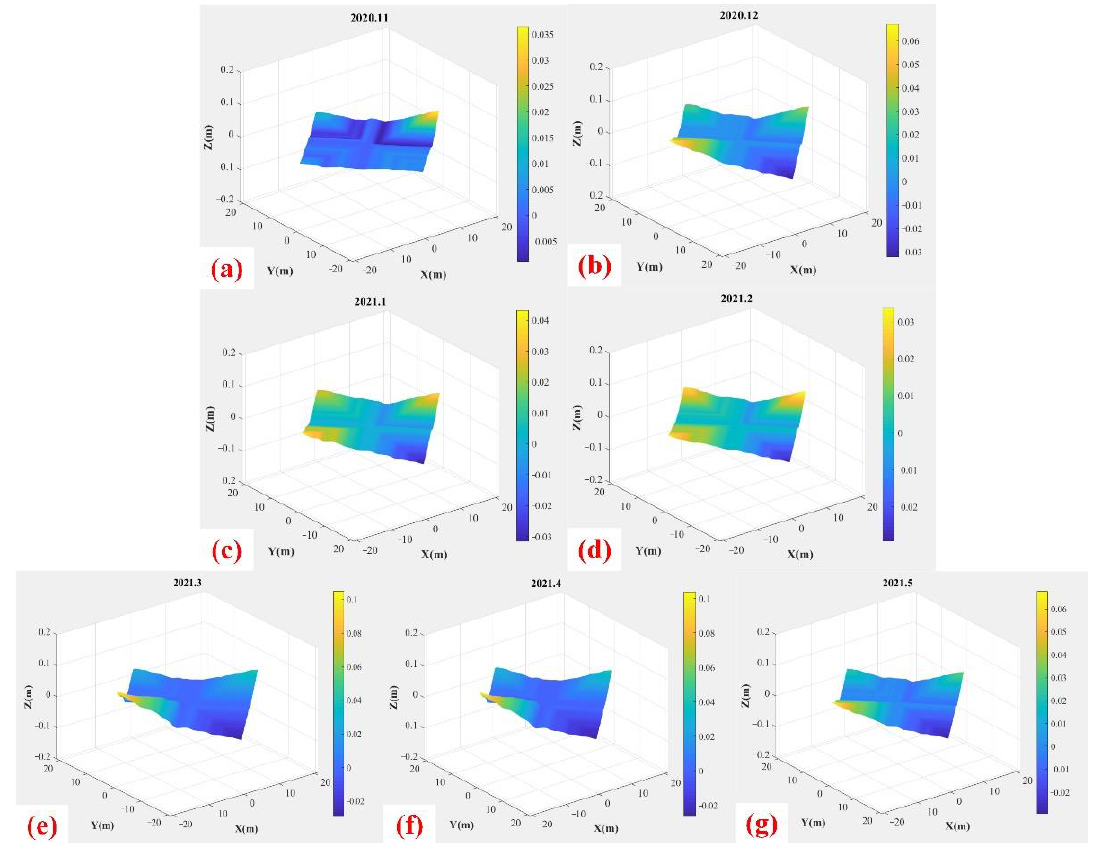
Figure 15. Terrain maps from November 2020 to May 2021. Table 3. Amount and velocity of subsidence and